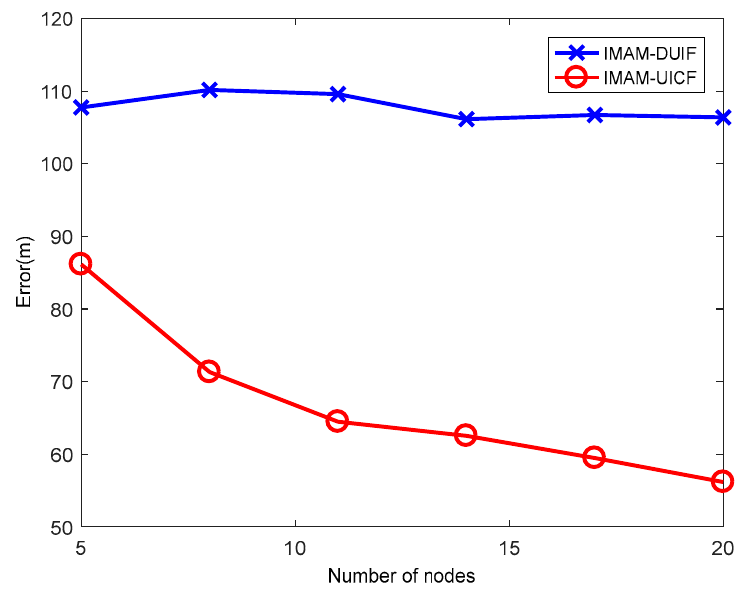
Figure 11. The position ARMSE of the two algorithms with varying number of sensors.